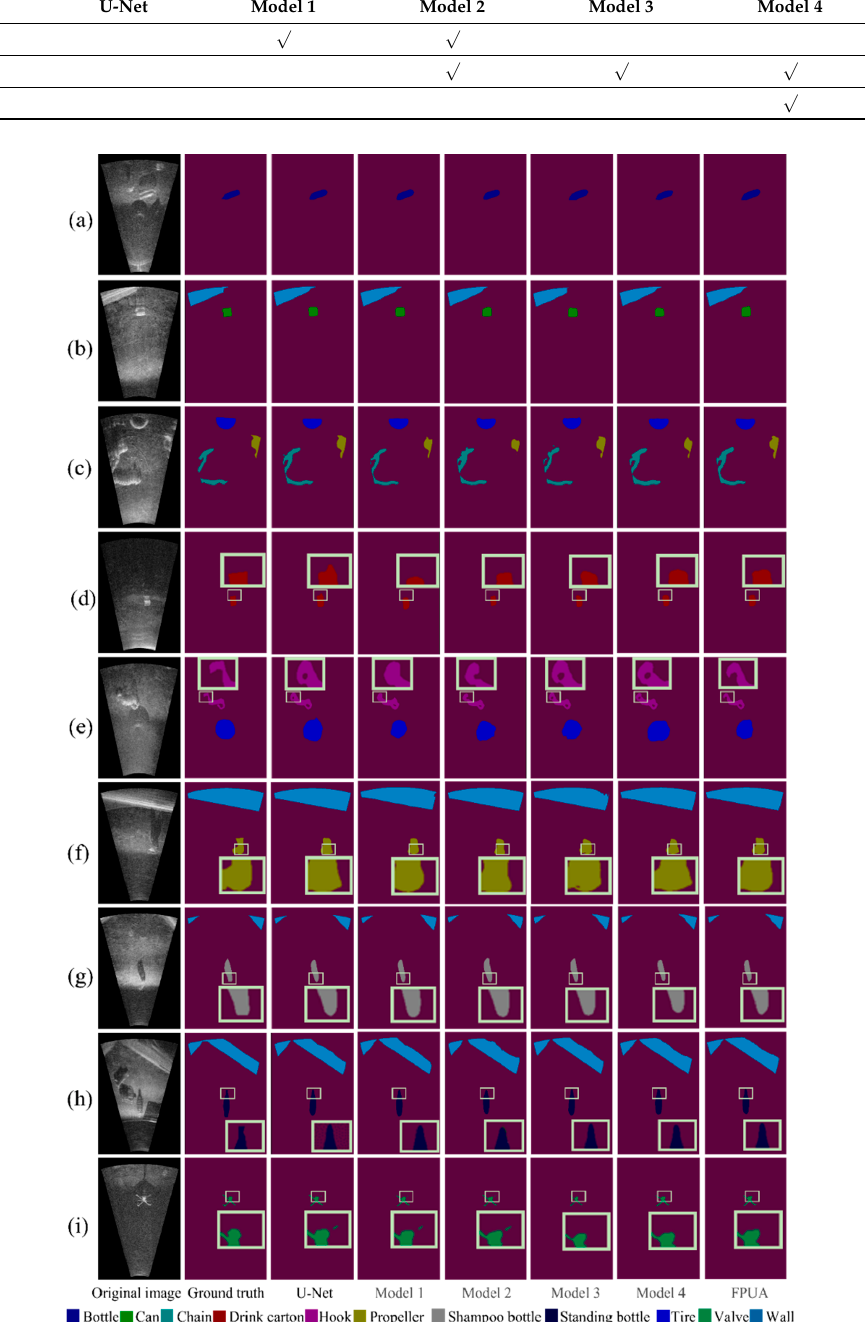
Figure 10. Segmentation results for each model in the ablation experiment. Subfigure ( a ) shows the segmentation effect of bottle, subfigure ( b ) shows the segmentation effect of can and wall, subfigure ( c ) shows the segmentation effect of chain, subfigure ( d ) shows the segmentation effect of drink carton, subfigure ( e ) shows the segmentation effect of hook and tire, subfigure ( f ) shows the segmentation effect of propeller, subfigure ( g ) shows the partition effect of shampoo bottle, subfigure ( h ) shows the partition effect of standing bottle, and subfigure ( i ) shows the partition effect of tire. The yellow box in the figure represents the enlargement of the details.